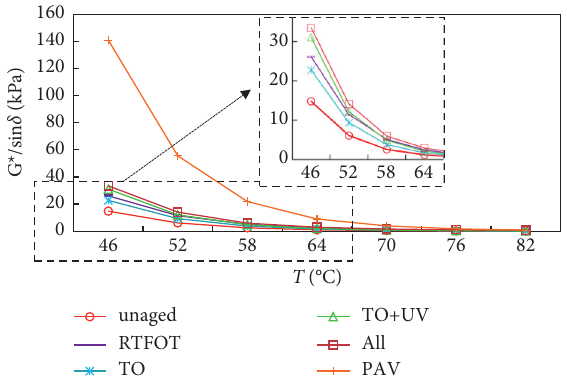
Figure 5: The variation curve of rutting factor with temperature of asphalt binder before and after aging.